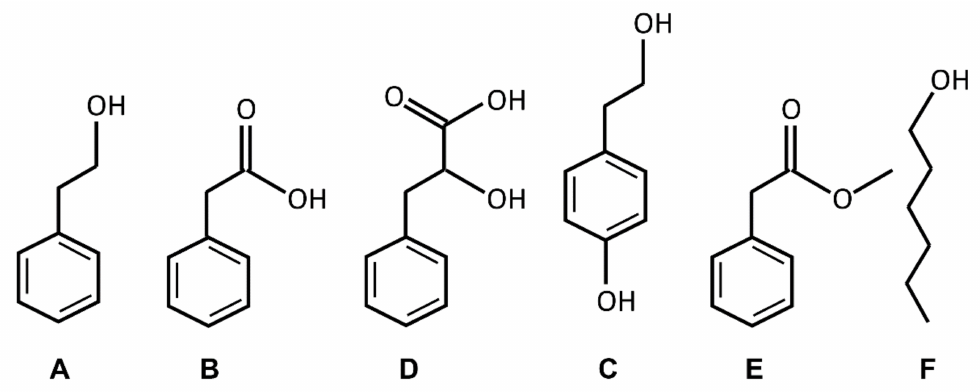
Figure 1. Chemical structures of 2-phenylethanol (2-PEtOH) and derivatives. 2-phenylethanol ( A ), phenylacetic acid ( B ), phenyllactic acid ( C ), Tyrosol ( D ), methyl phenylacetate ( E ), and 1-hexanol ( F ). The structures were drawn with ChemSketch